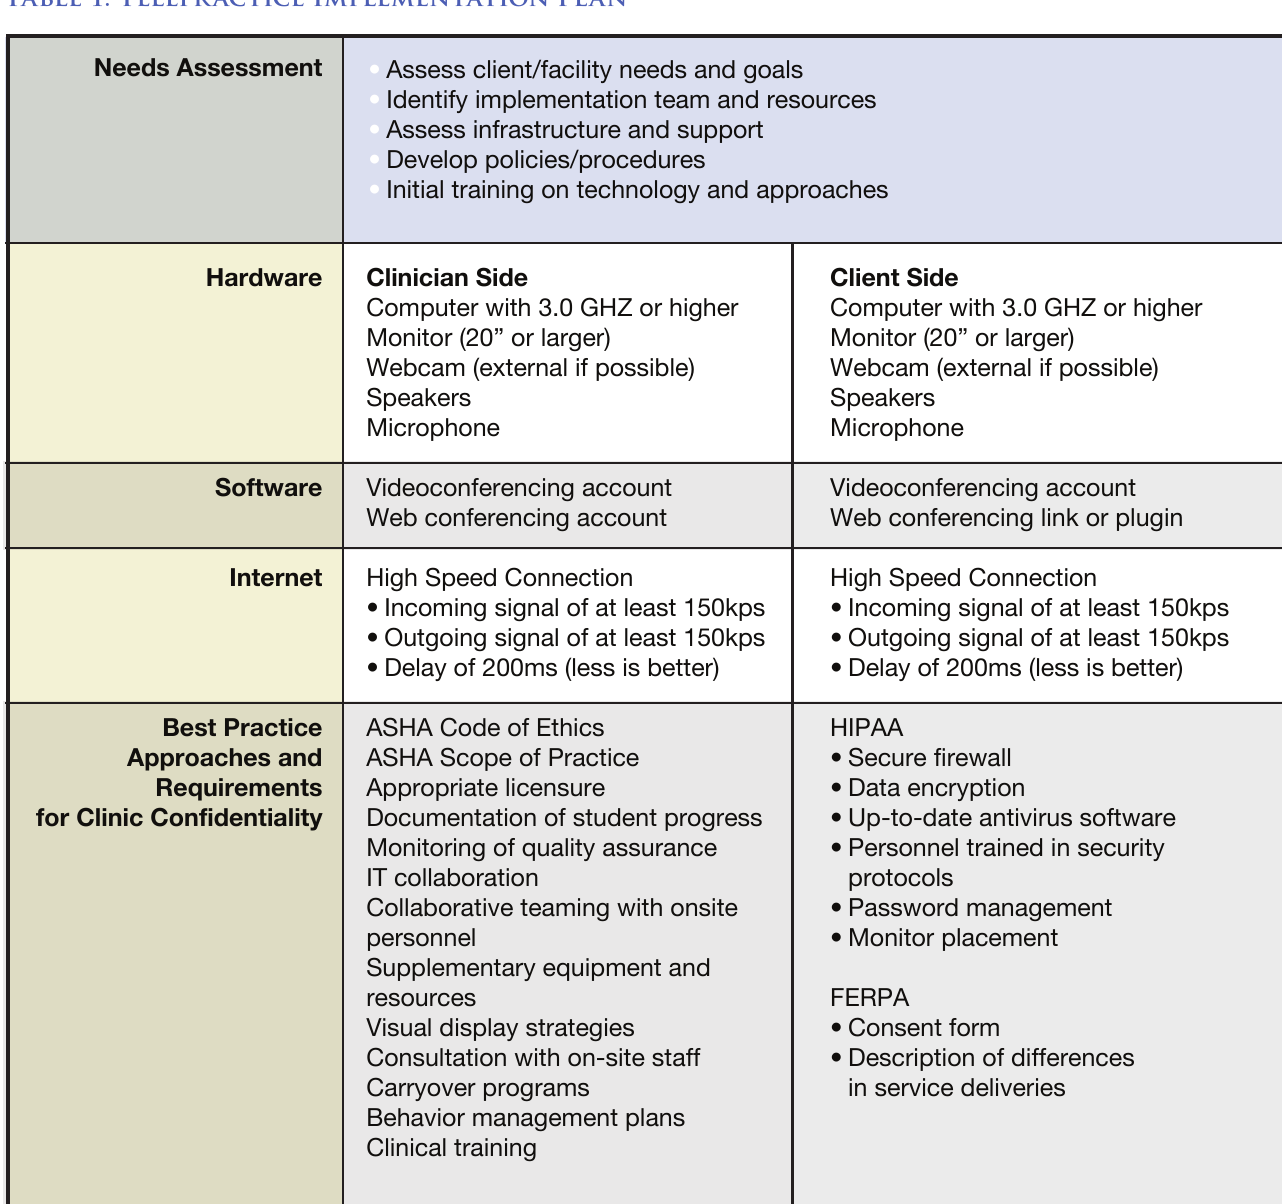
Table 1. Telepractice Implementation Plan